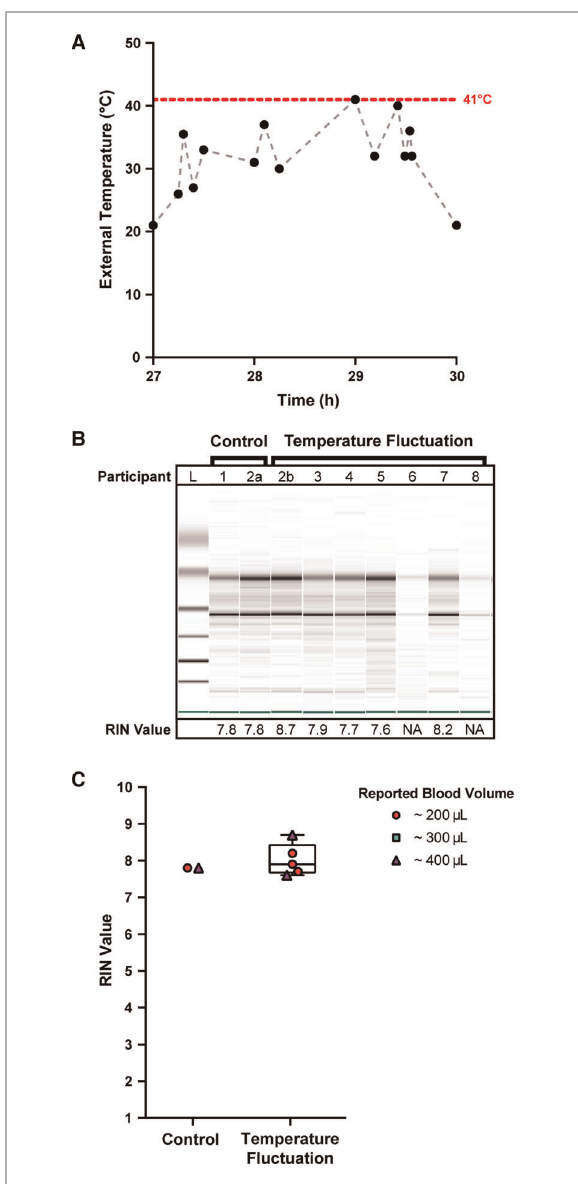
FIGURE 2 Quality of isolated RNA from stabilized home RNA samples exposed to high external temperature spikes in Doha, Qatar. (A) External temperature fl uctuation experienced by self-collected and stabilized blood samples after storage at ambient temperature (21° C) for 27 h. External temperature reached a maximum of 41°C. Black data points indicate the measured temperature; gray dashed lines are included to connect the points to guide the eye only (transitions between temperatures may not be linear). ( B ) Digital gel image of RNA isolated from home RNA blood samples with corresponding RIN values. Samples 2a and 2b were from the same participant. Samples 1 and 2a did not undergo temperature fl uctuations (they were frozen down at − 80°C after overnight ambient temperature incubation to use as controls). ( C ) Scorable RIN values for each blood sample not exposed (control) and exposed (temperature fl uctuation) to high temperature spikes along with the reported approximate blood volume collected by each participant. Participants 6 and 8 yielded too low of a RNA concentration to be detected using the RNA 6000 Nano